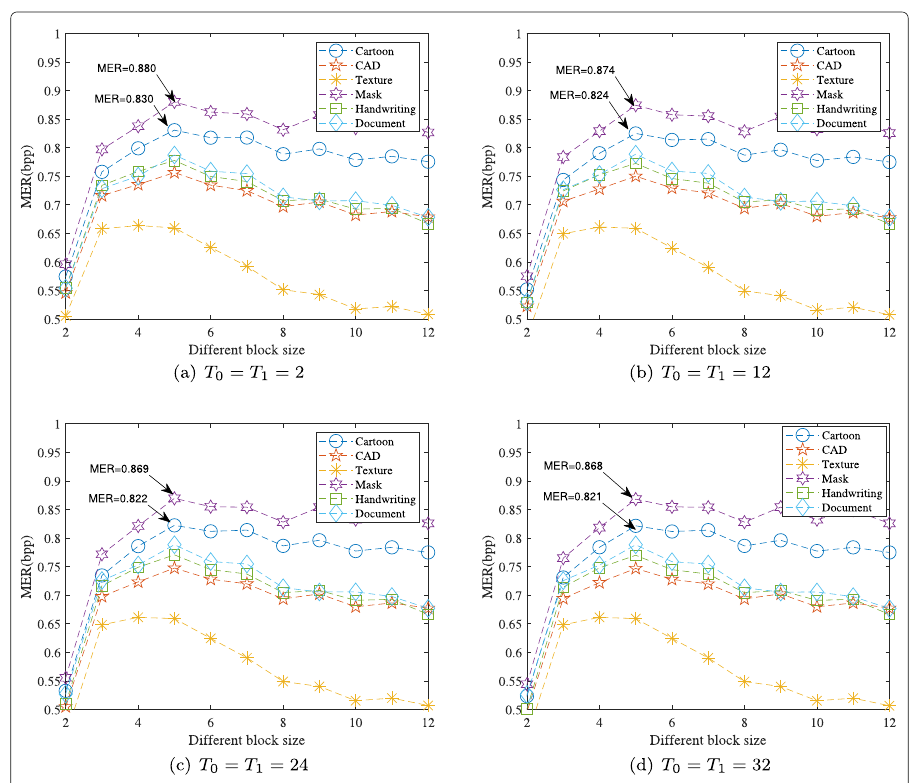
Fig. 10 Comparison of the maximum embedding rate (MER) with block size N changing for four different compression thresholds a T 0 = T 1 = 2, b T 0 = T 1 = 12, c T 0 = T 1 = 24, and d T 0 = T 1 = 32. Six classical binary images, (8) Cartoon, CAD, Texture, Mask, Handwriting, and Document, are tested in this